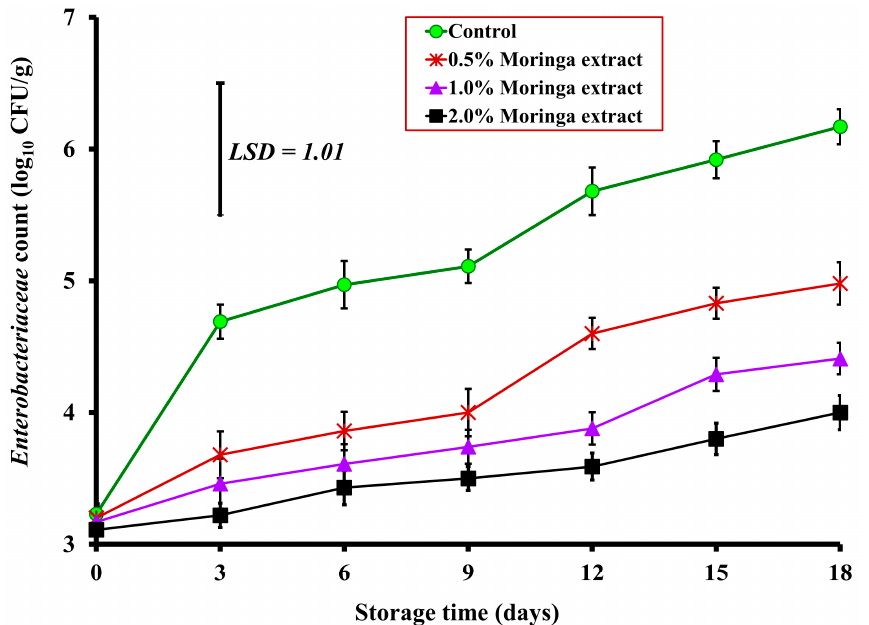
Figure 2. Effect of Moringa oleifera leaves extract supplemented to ground beef on the Enterobacteriaceae counts (log 10 CFU/g) during cold storage at 4 °C for 18 days. The displayed values represented the mean of triplicate measurements ± standard error (SE).